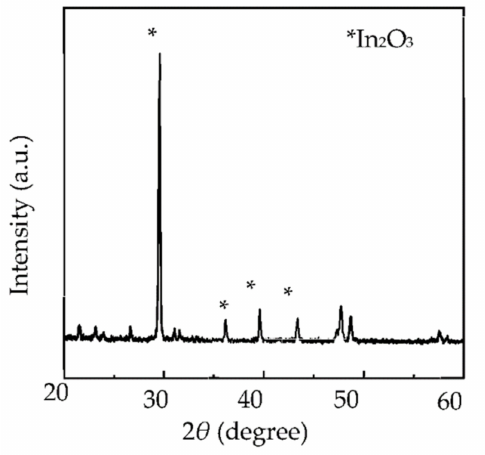
Figure 2. XRD patterns of the regenerated ITO thin film after extraction of copper species with IL-I at 303–543